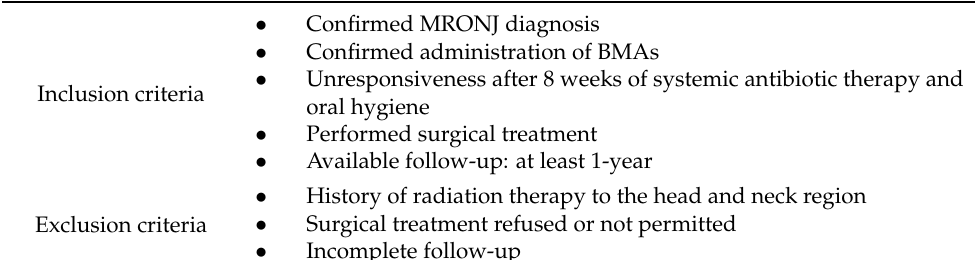
Table 1. Inclusion and exclusion